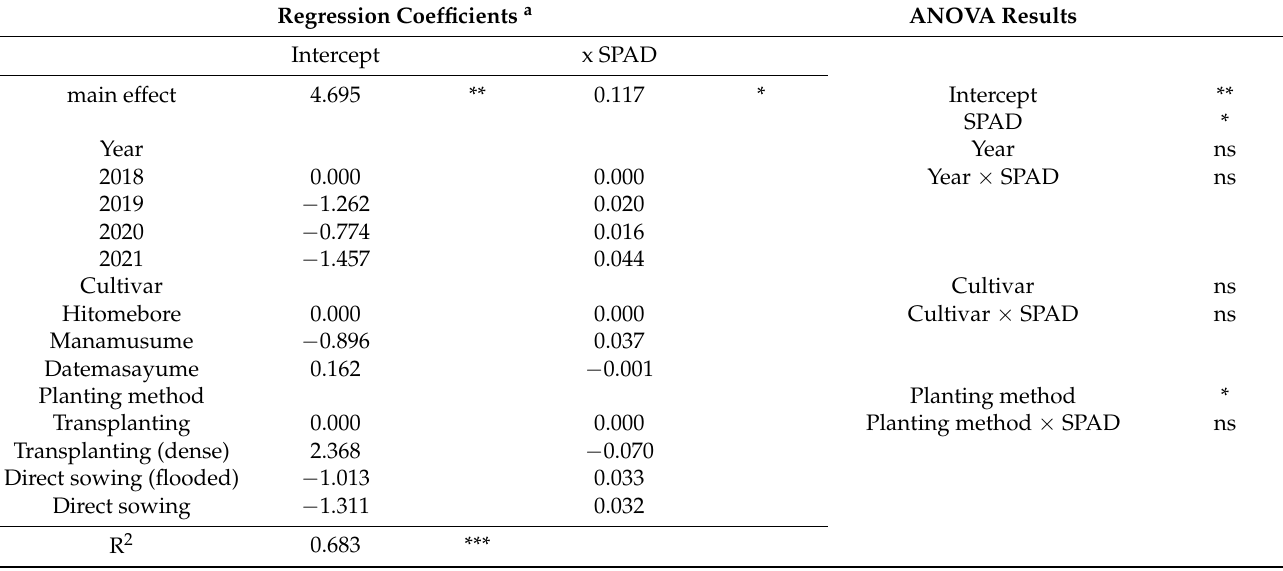
Table 5. Regression coefficients and ANOVA results by Equation (2) for maturity